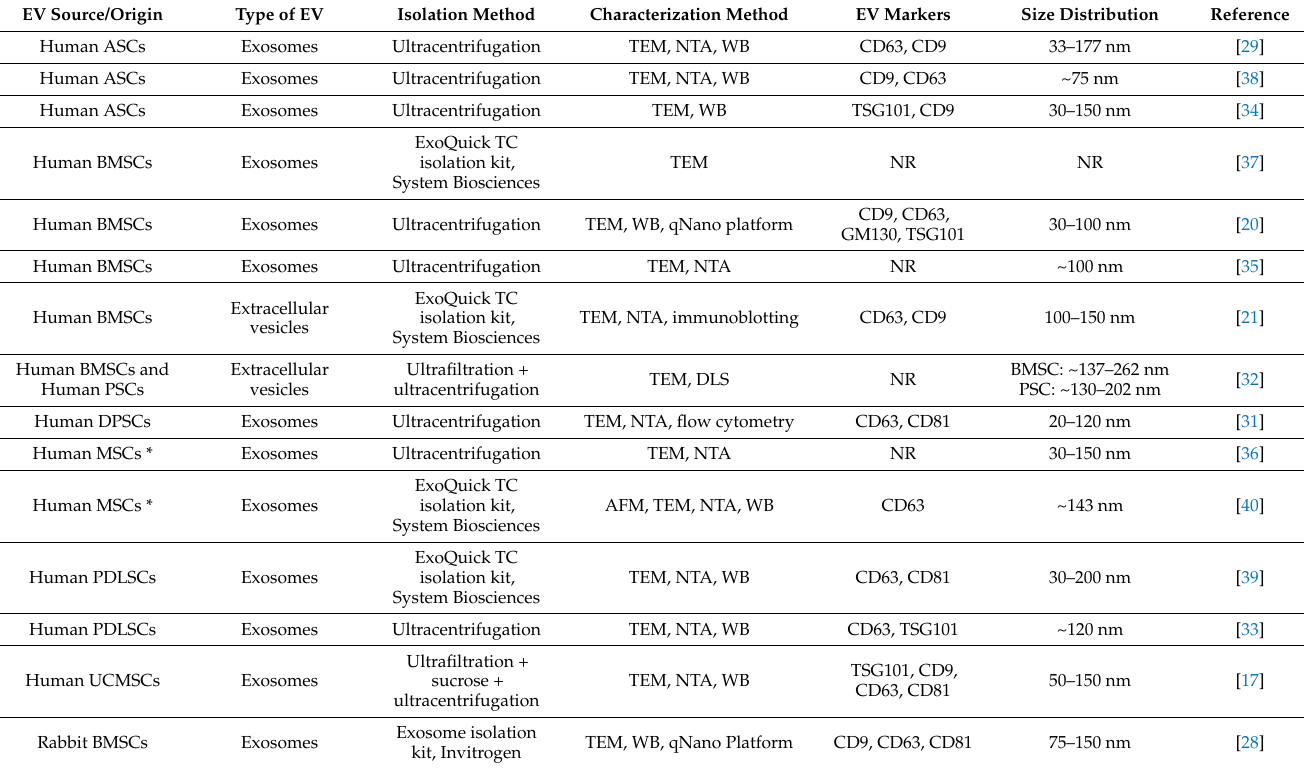
Table 2. Methodology information for EV